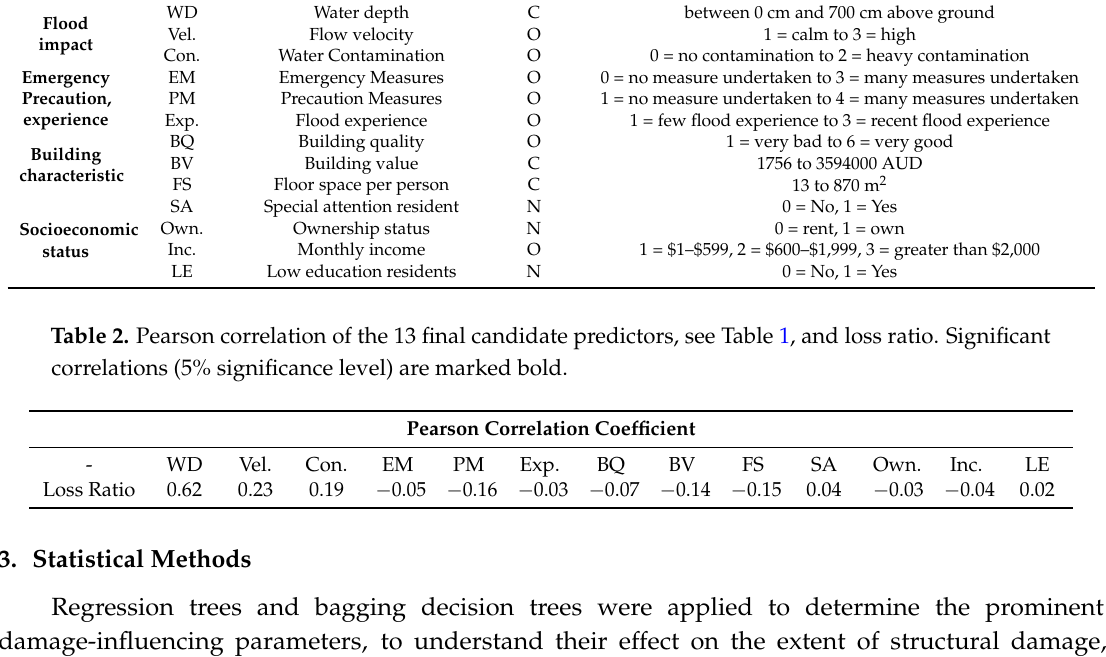
Table 1. Description of the 13 candidate predictors (C: continuous, O: ordinal, N: nominal). Categories Type